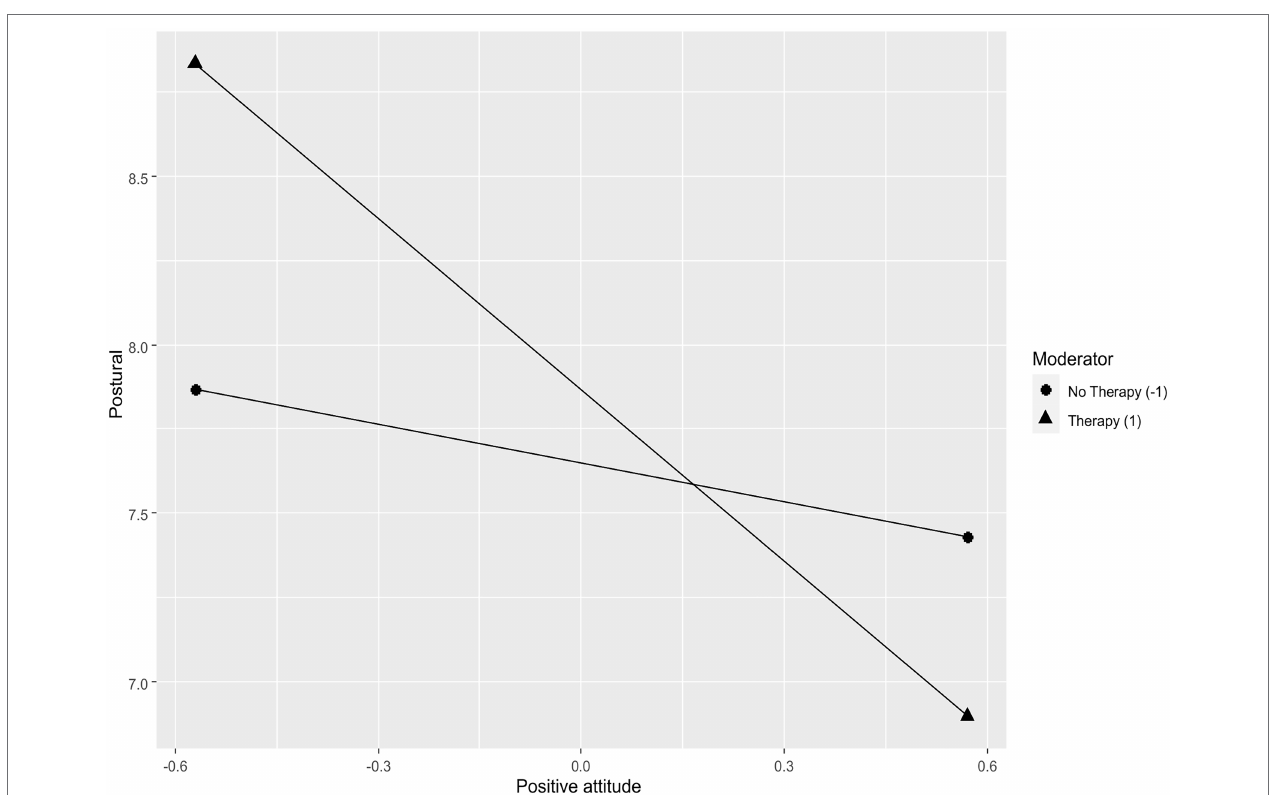
FIGURE 3 | Simple slope showing the role of psychotherapy as moderator in the relationship between postural and positive